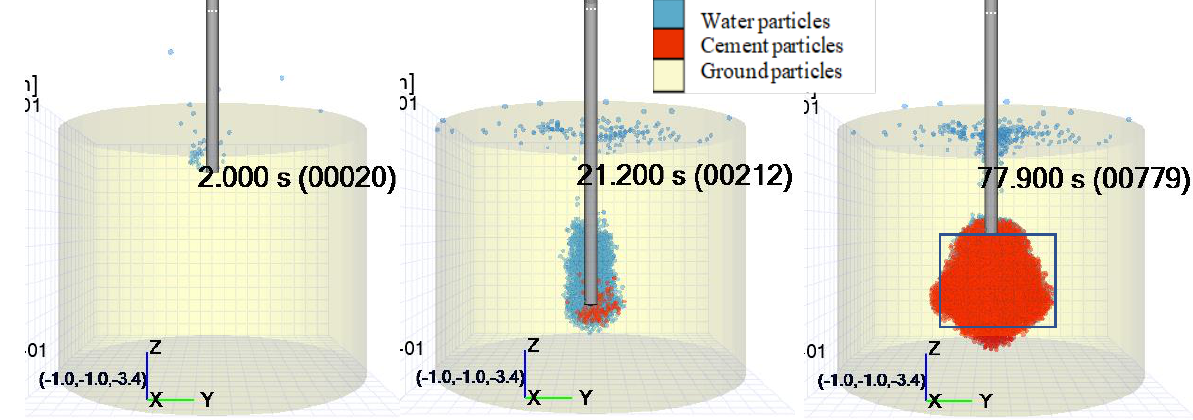
Figure 8. Reproduction of development condition of the soil-improved body.